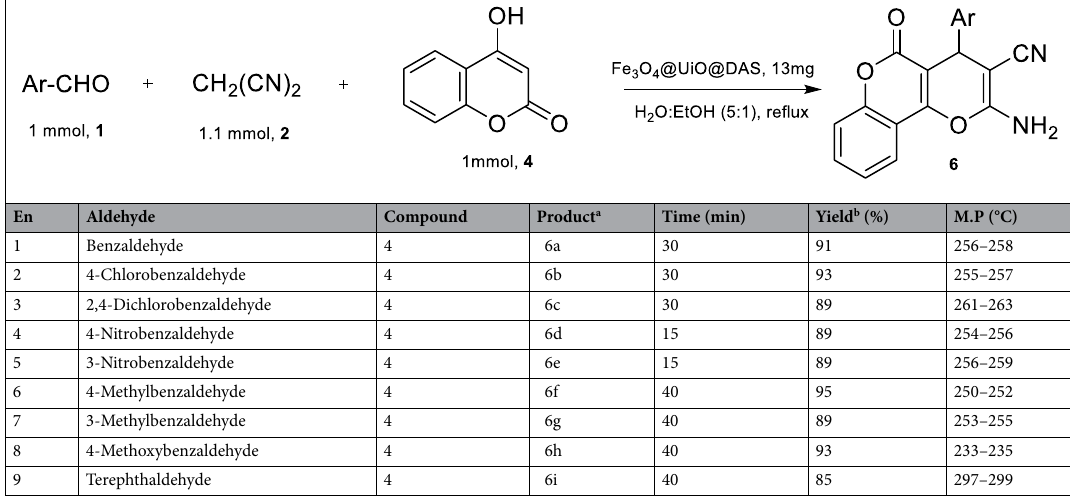
Table 4. Three-component synthesis of different 2-amino-5-oxo-4-phenyl-4,5-dihydropyrano[3,2- c ] chromene-3-carbonitrile (6a–i) via condensation of various aldehydes (1), malononitrile (2), and